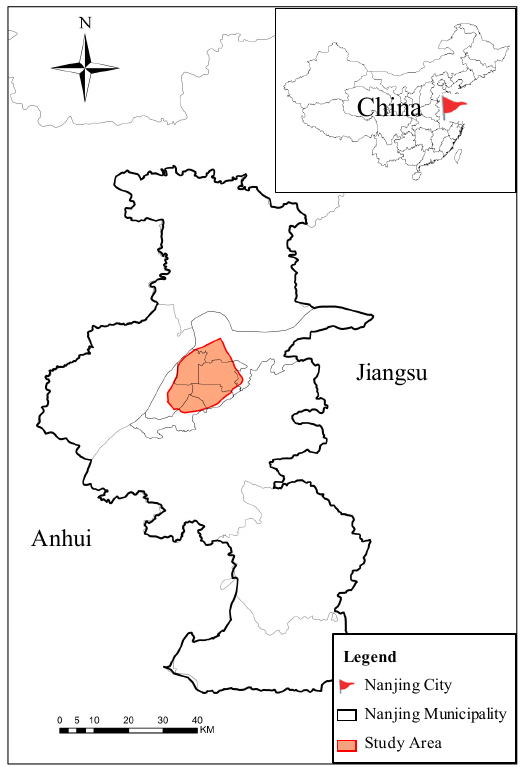
Figure 1. Location of Nanjing, China.